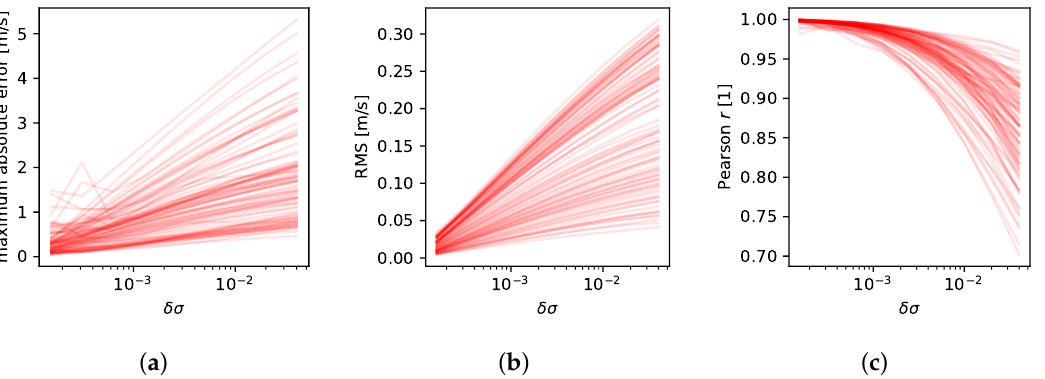
Figure 12. Convergence analysis over the whole domain for the period of hurricane Odile, 14 September 2014–18 September 2014. ( a ) Maximum absolute velocity error, err = | v − v δσ (cid:112) ( b ) root mean square error, RMS = 1/ N ∑ err 2 , with N denoting the grid points with an initial depth of more than 3m, and ( c ) Pearson correlation coefficient, r .